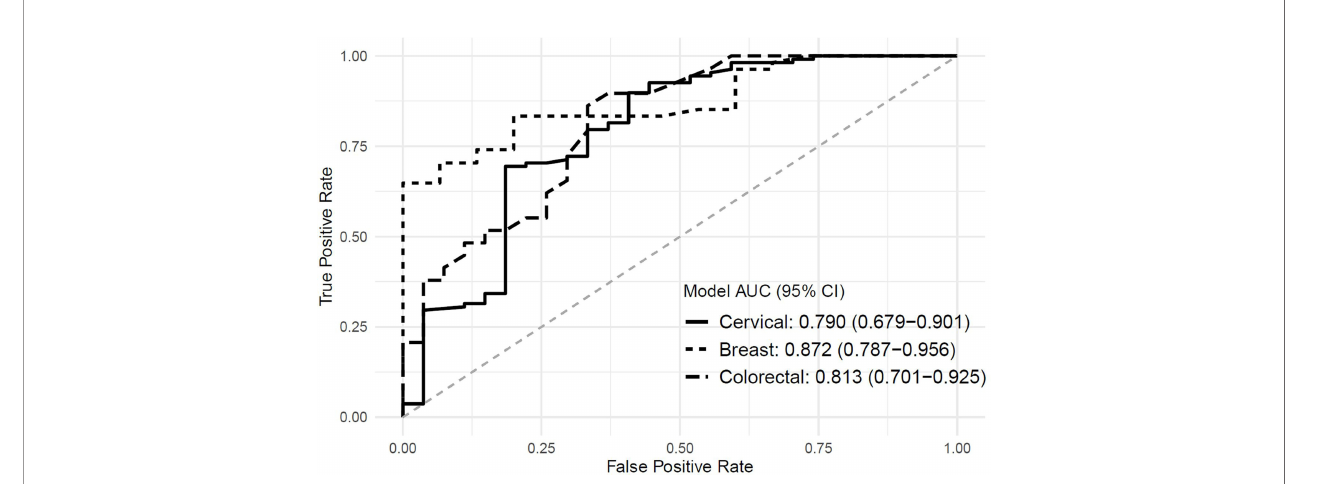
FIGURE 3 | Area Under the curve for multiple logistic regression screening